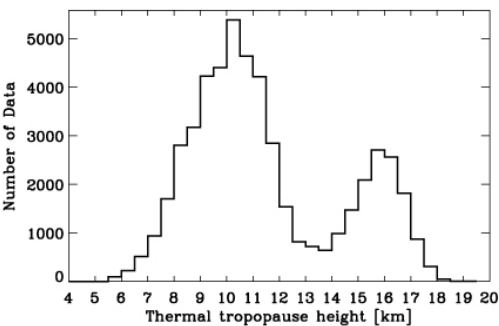
Fig. 2. Histogram of thermal tropopause heights collected from global ozonesonde soundings from 1983 to 2008. The WMO defi- nition (1957) is applied to determine the thermal tropopause